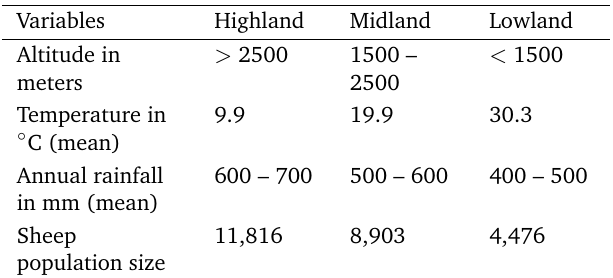
Table 1. Climatic factors and sheep population size of the threeagro-ecological zones in the Tahtay Maichew district of Tigray region,